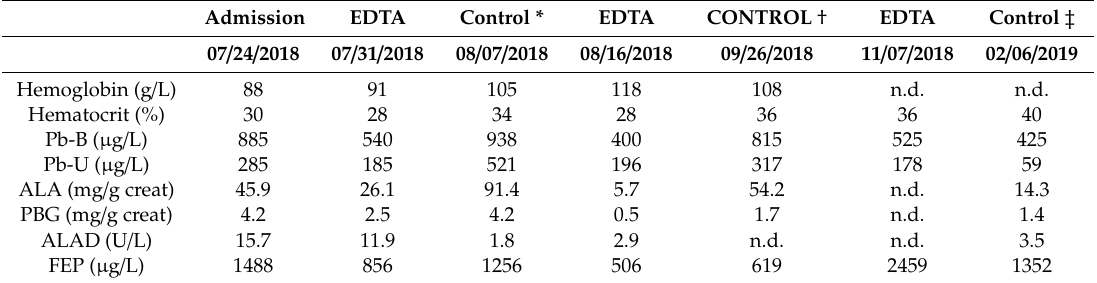
Table 1. Results of blood and toxicological test before and after every cycle of therapy.